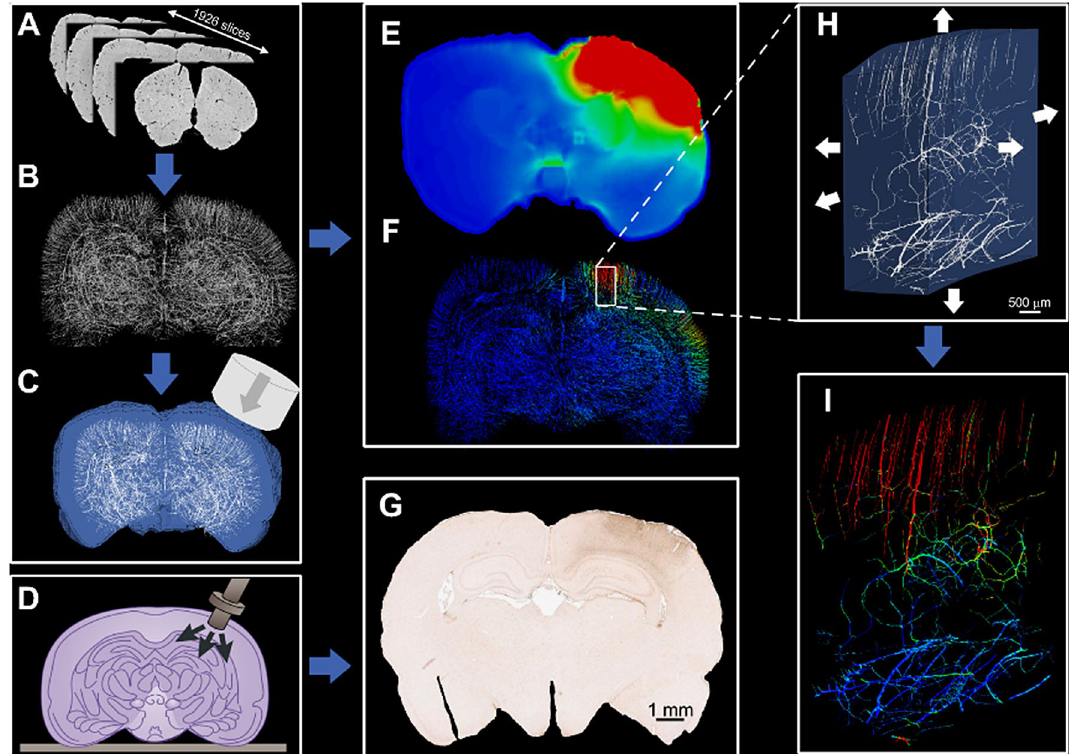
Figure 6. General workflow of this paper; ( A ) brain images acquired using SR-PCI technique, ( B ) FE model of the brain angioarchitecture, ( C ) FE model of CCI illustrating the impactor, brain tissue (blue) and vasculature (white), ( D ) schematic illustration of controlled cortical impact, ( E ) maximum value of the first principal strain of the brain tissue (red and blue colours show 50% and 0, respectively), ( F ) maximum axial stress within the vasculature (red and blue colours show 500 and 0 kPa respectively), ( G ) fibrinogen extravasation measured by immunohistochemistry (IHC) staining, ( H ) mapping the displacement at the borders of a region of interest for the microscale modelling, ( I ) vessels axial stress distribution of the microscale model of a region of interest (red and blue colours show 500 and 0 kPa